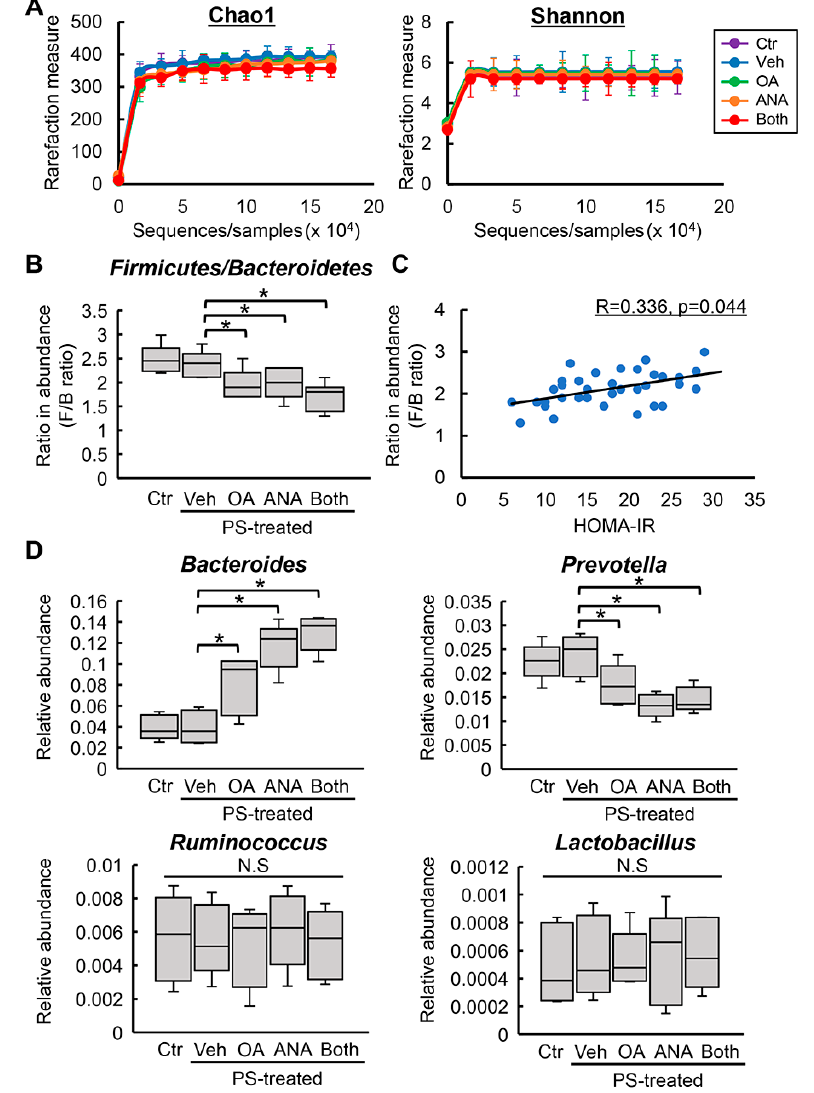
Figure 6. Changes in rat fecal microbiota by oleanolic acid and anagliptin. ( A ) Comparative analysis of Chao1 richness and Shannon diversity in fecal microbiome of the experimental groups. ( B ) The ratio of Firmicutes:Bacteroidetes (F/B) at the phylum level in the experimental groups. ( C ) Univariate correlation analysis between the ratio of F/B and the values of HOMA–IR in the experimental OLETF rats. ( D ) Relative abundances of Bacteroides , Prevotella , Ruminococcus , and Lactobacillus at the genus level in the experimental group. Ctr; negative control group, Veh; vehicle-treated PS-injected group, OA; oleanolic acid-treated PS-injected group, ANA; anagliptin-treated PS-injected group, Both; oleanolic acid and anagliptin-treated PS-injected group. Data are means ± SD ( n = 5). *, P ≤